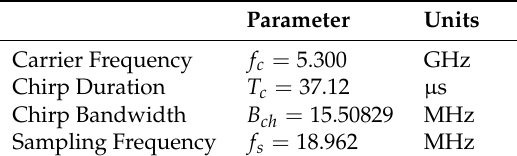
Table 2. ERS radiometric parameters.